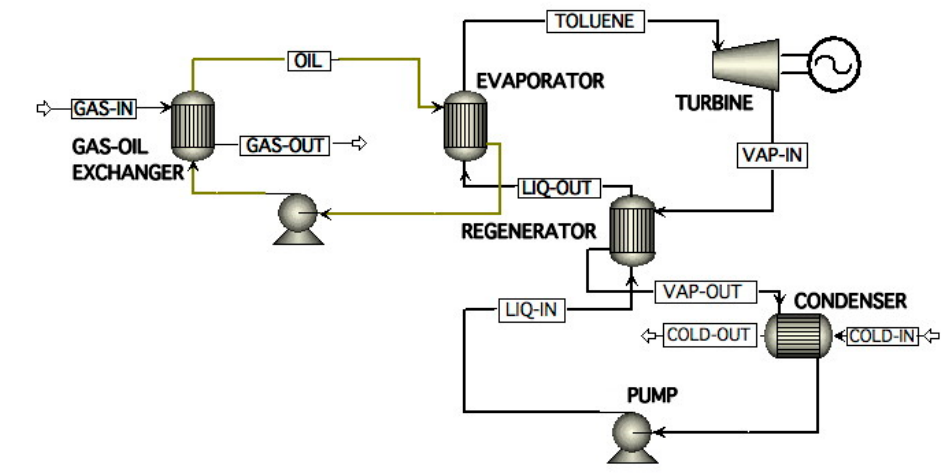
Figure 8. Regenerated ORC cycle.